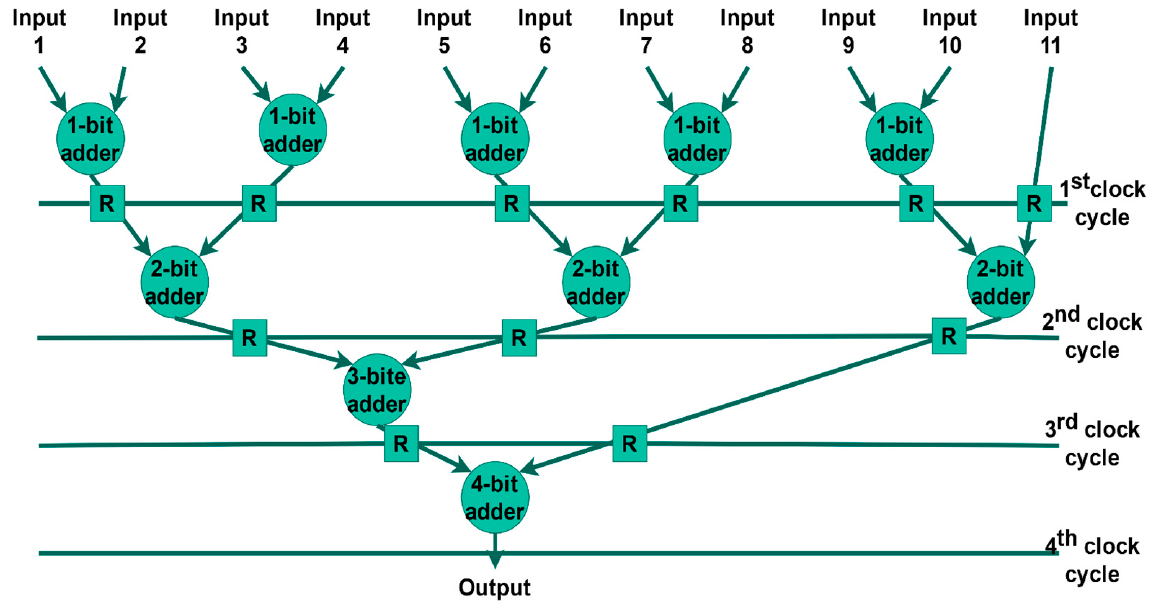
Figure 1. Adder tree for an 11-bit model. The circles are adders of appropriate size for each level, while the squares represent registers. The addition of registers between the levels of adders enables pipelining. At each level, the numbers are added in pairs. If there is a leftover number, it proceeds as previously set. This means that in level i , there are n ( n )) and ceil(log 2 n ) levels in total. The final sum is also ceil(log 2 n ) bits in length. The 2 i largest adder needed is ceil(log 2 n ) − 1 bits. The critical path of this adder determines